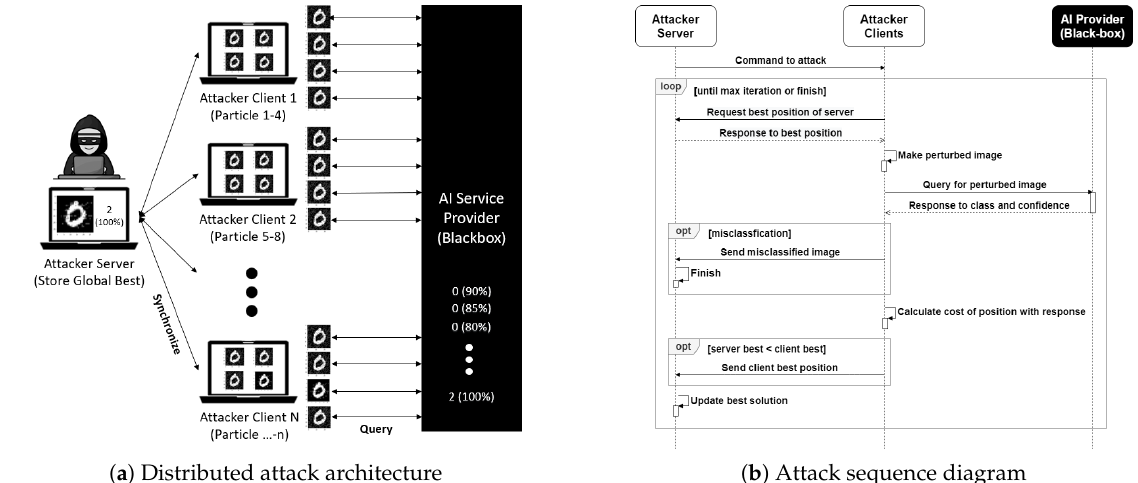
Figure 1. Architecture overview of distributed black-box adversarial attack using Multi-Group Particle Swarm Optimization with Random Redistribution